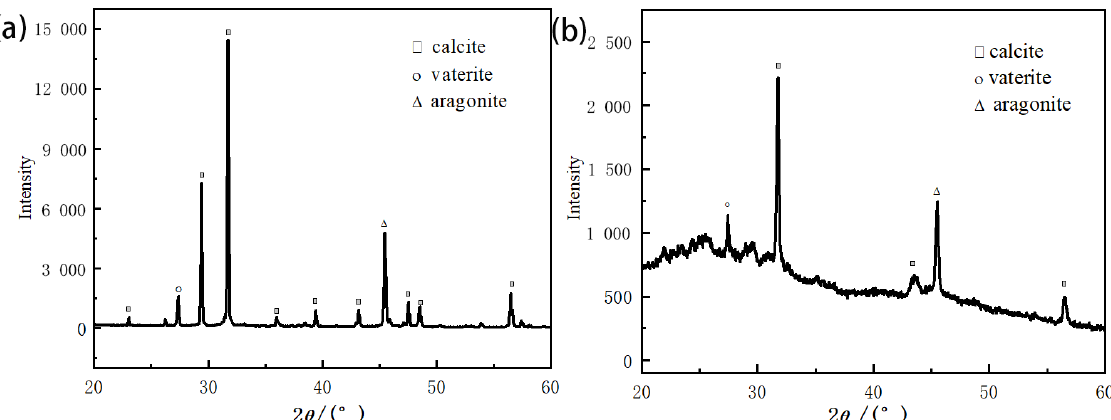
Figure 11. XRD of calcium carbonate crystals: ( a ) XRD of calcium carbonate without scale inhibitor and ( b ) XRD of Calcium Carbonate with Scale Inhibitor.